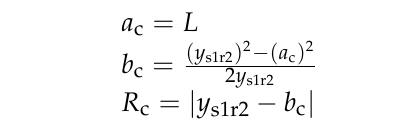
Table 5. Defining parameters of the